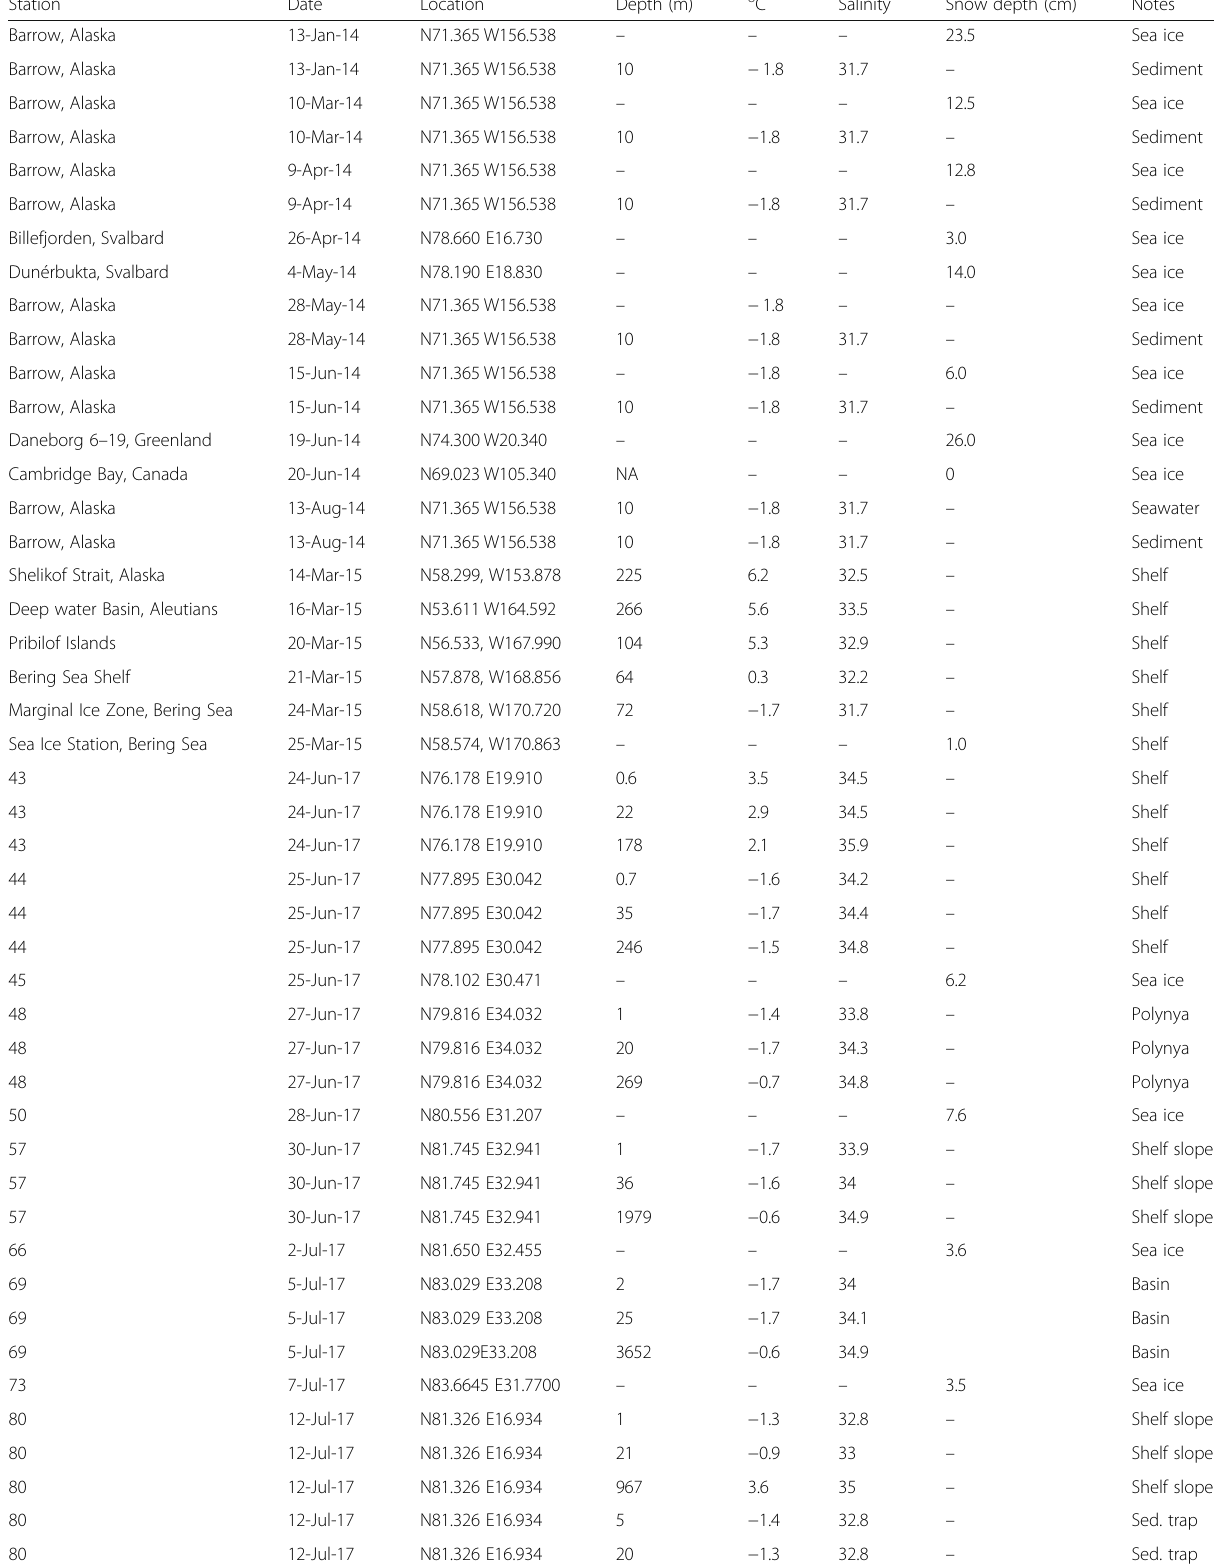
Table 1 Metadata sheet of sites sampled and analyzed for Oomycota